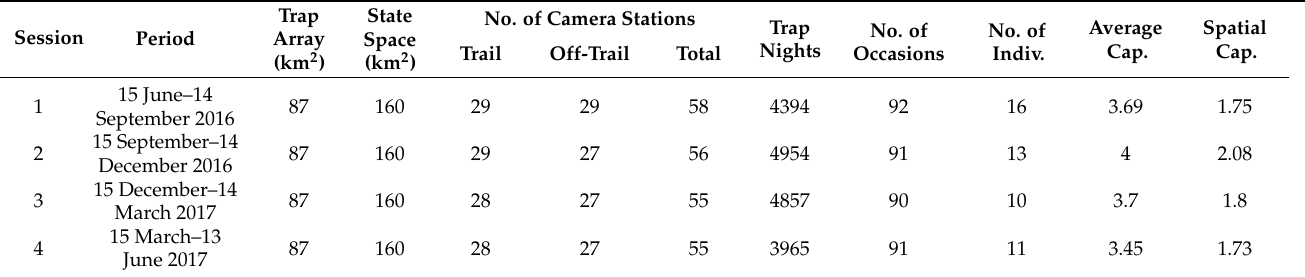
Table 2. Sampling effort for a jaguar camera trap density study in Sector Santa Rosa, Guanacaste Conservation Area, Costa